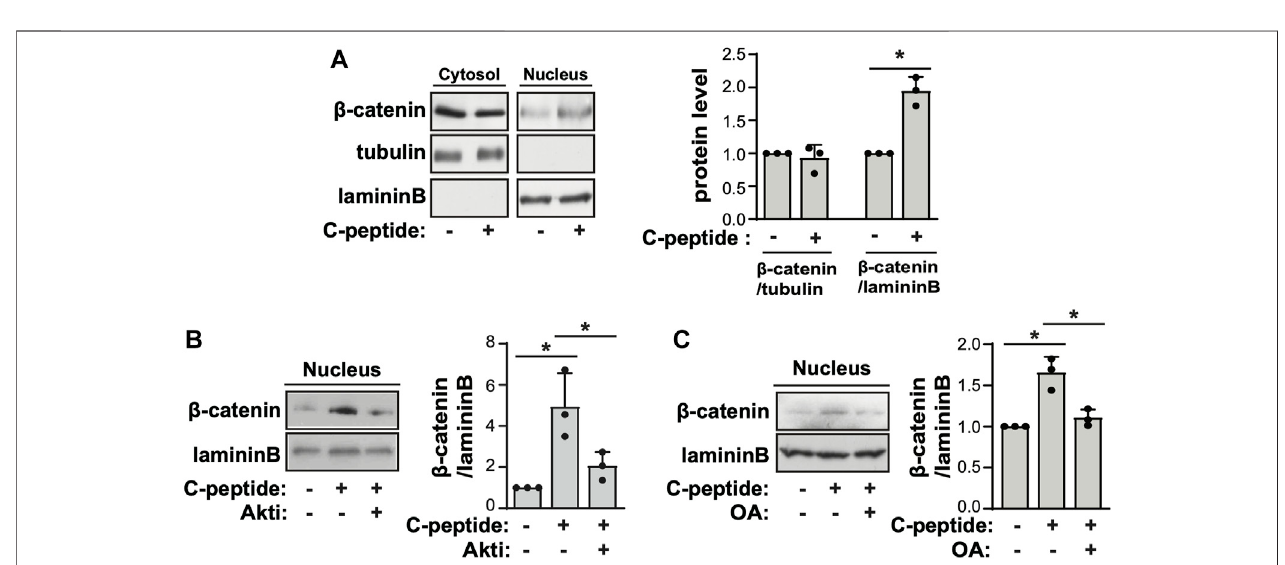
FIGURE3| C-peptide induces β -catenin nucleartranslocation in anAkt and protein phosphatase-dependent manner. (A) Theundecidualized human endometrial stromal cells (UnD-ESCs) were serum-starved for 48 h, incubated with 50 nM C-peptide for 10 min, and later lysed using cytoplasmic protein extraction buffer. The cytoplasmic and nuclear extracts were fractionated using the cytoplasmic and nuclear protein extraction buffers, respectively. Both cell lysates were subjected to western blot analysis. Tubulin and laminin B were used as cytoplasmic and nuclear markers, respectively. (B,C) The cells were pretreated with 1 μ M Akti (B) or 10 nM OA (C) and treated as described in (A) . Nuclear cell lysate was analyzed by western blot. The intensities of western blots were quanti fi ed using ImageJ software. The relative β -catenin level wascalculated bycomparingtubulin level for thecytoplasmic fraction and lamininB forthe nuclear fraction, respectively. Asterisks (*) indicate signi fi cant differences ( p < 0.05) when compared to C-peptide untreated UnD-ESCs control or C-peptide treated UnD-ESCs control. Akti, Akt inhibitor; OA, Okadaic acid.